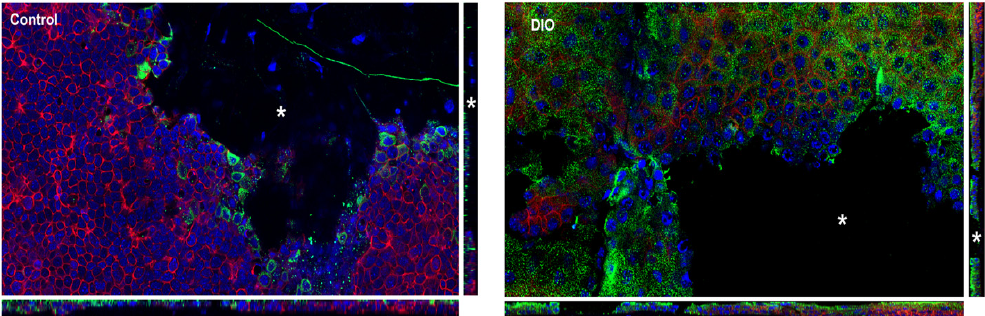
Figure 4. Change in Crb3 after epithelial injury. Maximal projection images were taken, and orthogonal images made. The side bars show cross-sections with an apical-basal view of Crb3 (green), DAPI (blue) and actin (red). Asterisk denotes wound.